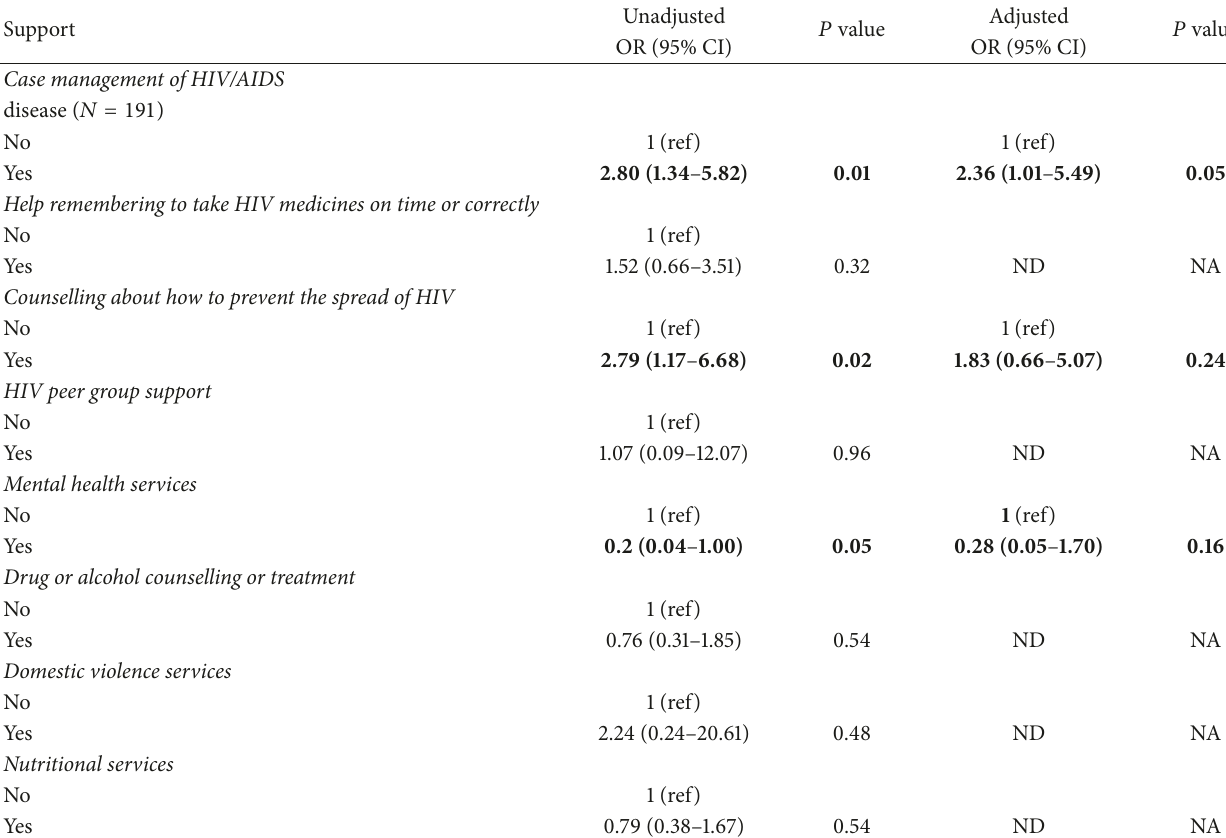
Table 7: Univariate and multivariate analysis of support services participants received (12 months prior to the study), in association with their most recent CD4 count